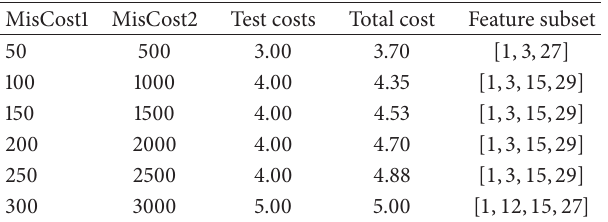
Table 14: The optimal feature subset based on different misclassifi- cation